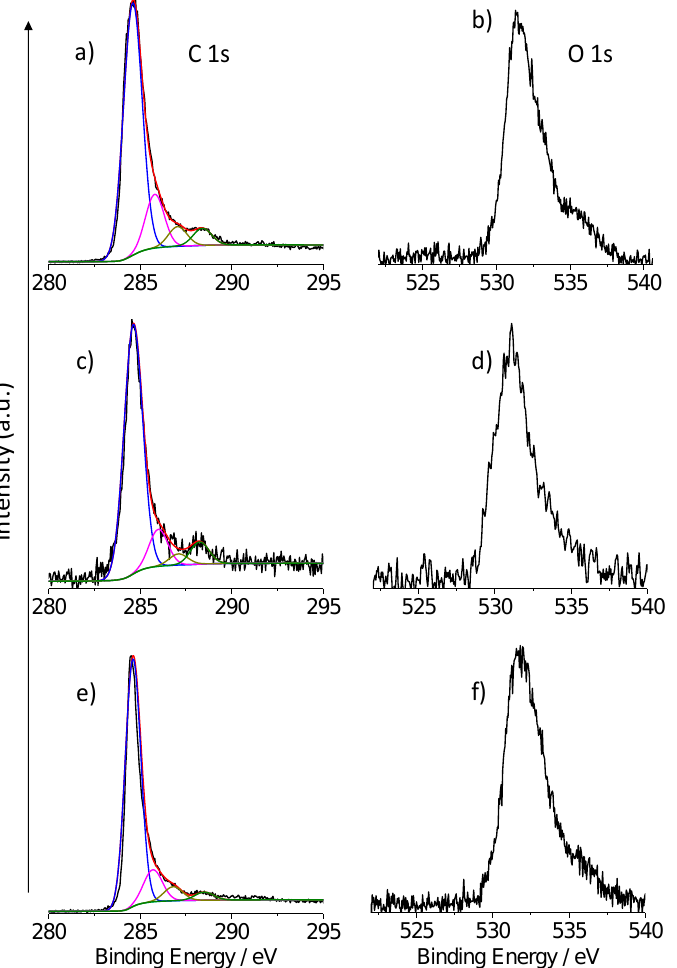
Figure 6. Al-K α excited XPS in the binding energy region of C 1s: ( a ) Pd-GP; ( c ) Pt-GP; ( e ) Pt 80 Pd 20 -GP. The component positions are reported in Table 1. O 1s binding energy region of: (b ) Pd-GP; ( d ) Pt-GP; ( f ) Pt 80 Pd 20 -GP.